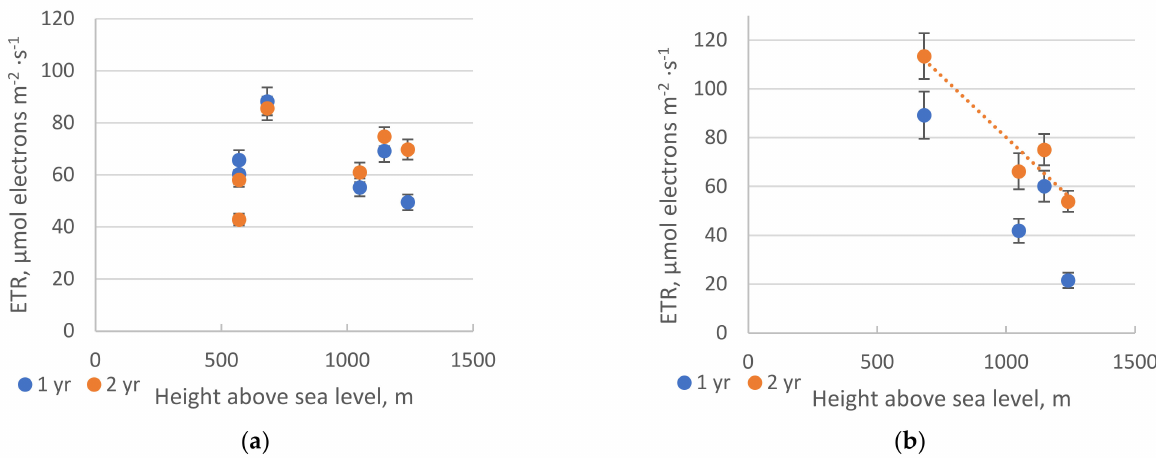
Figure 1. Electron–transport rate (ETR) in one– and two–year–old needles of P. sibirica ( a ) and A. sibirica ( b ). The significant slope is shown on the graph. Pearson analysis revealed significant linear regression in A. sibirica for two–year–old needles ( p < 0.05). The vertical bars represent the standard deviation. From each sample point, three measurements of both one– and two–year old needles were taken. Here and further “yr” = year.